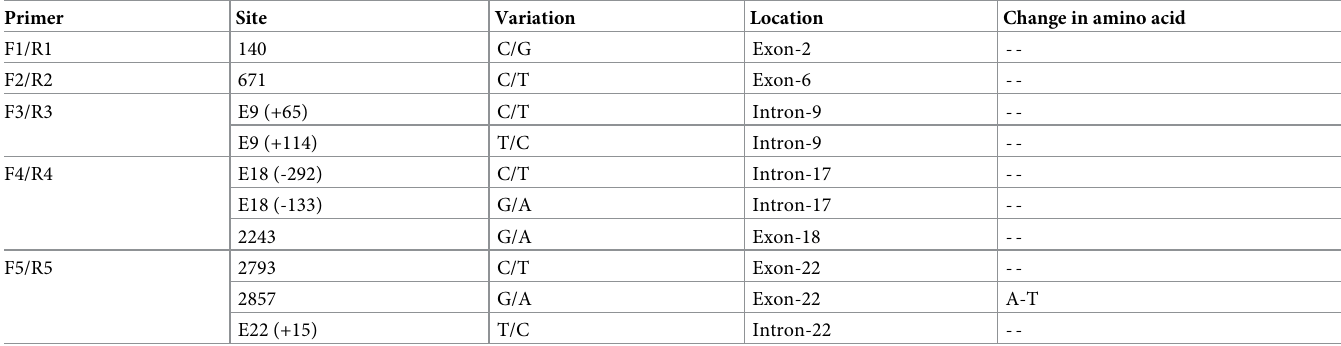
Table 2. SNP sites and change in amino